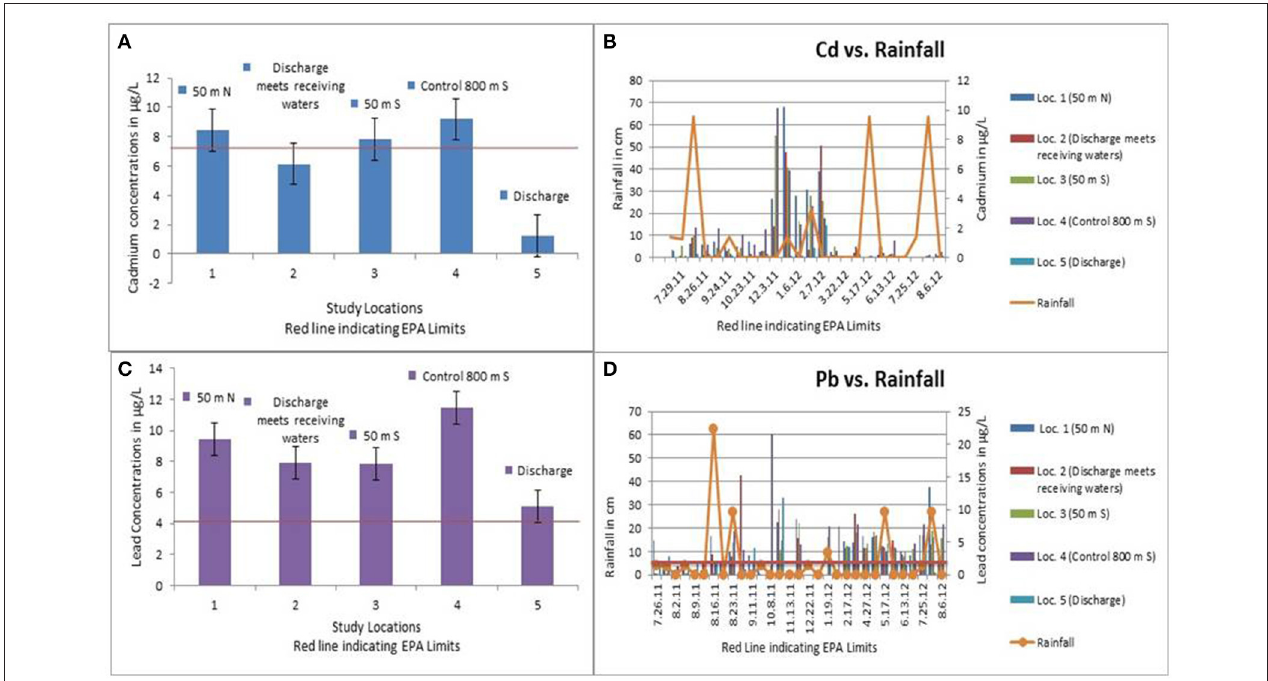
FIGURE 3 | (A) The concentrations of cadmium in the water samples collected from the study locations (Cannon et al., in press). (B) The concentrations of lead in the water samples collected from the study locations ( Cannon et al., in press). (C) Relationship between rainfall and cadmium levels in the water samples (Cannon et al., in press). (D) Relationship between rainfall and lead levels in the water samples (Cannon et al., in